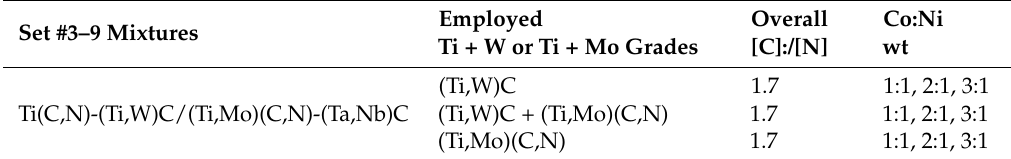
Table 3. Pre-alloyed hard phases, varying Co:Ni